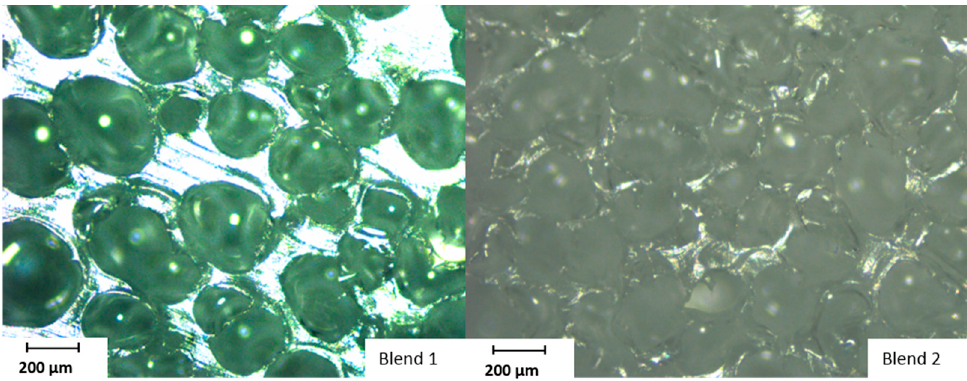
Figure 13. Cell density of foamed samples with pure talcum (blend 1) and modified talcum (blend 2).